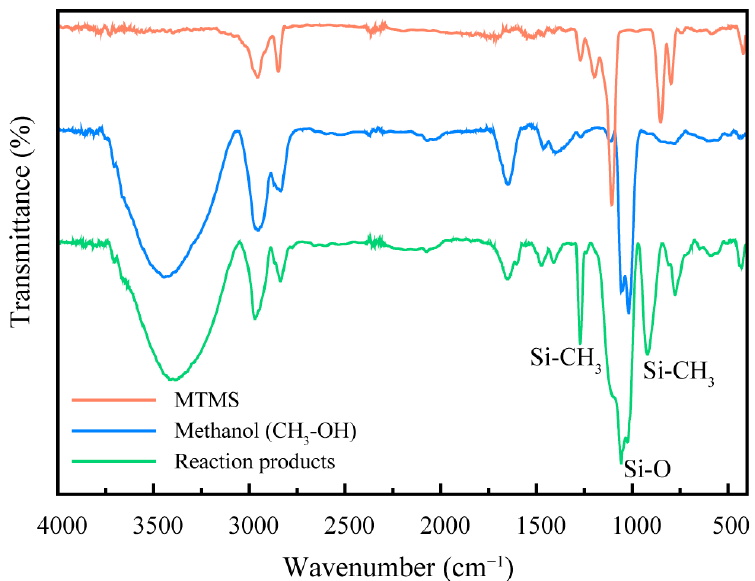
Figure 3. Structure schematic of SMPR.